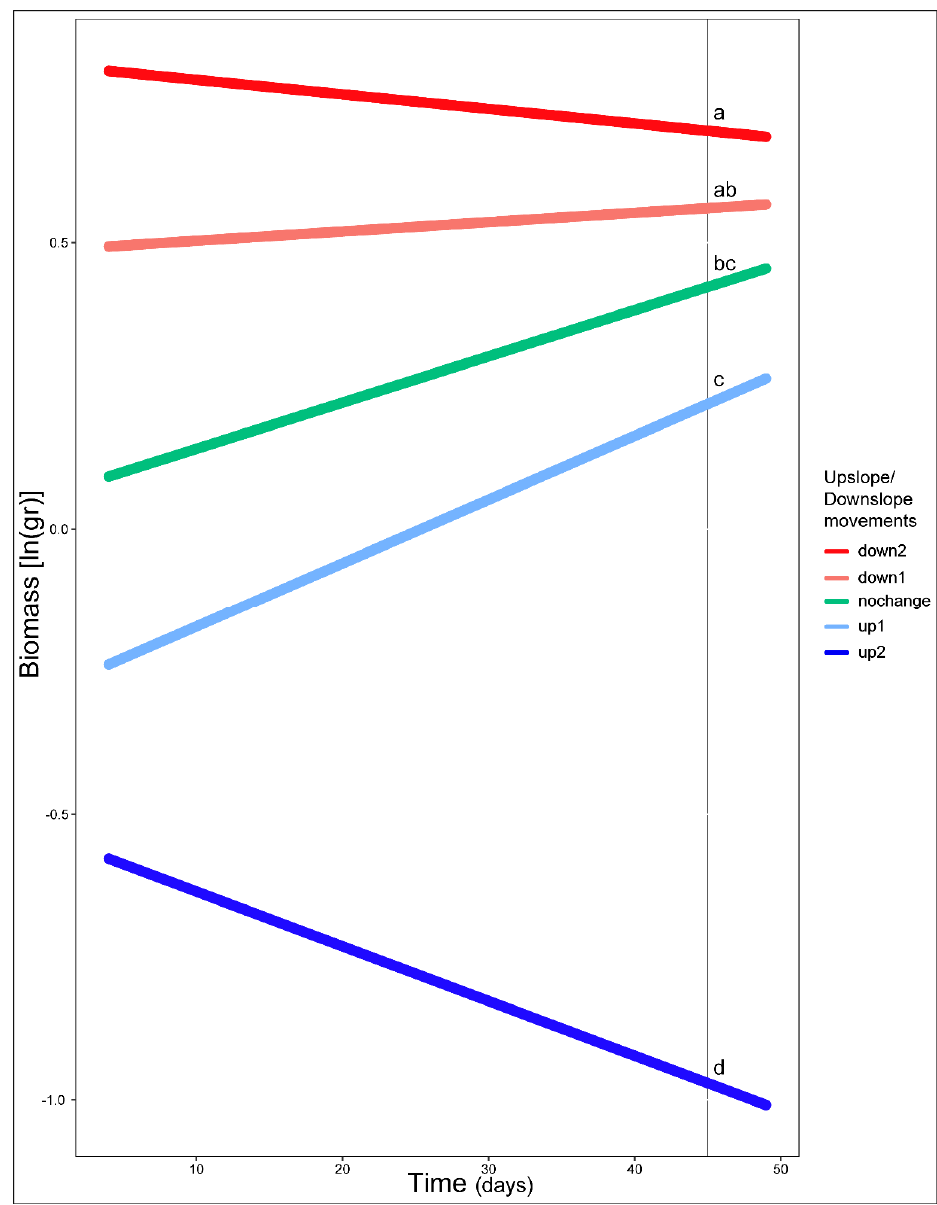
Figure 1. Estimated performance of Erebia caterpillars as predicted for the three temperature treat- ments (low, medium, high) and across time. Lowercase letters indicate differences between treat- ments. Model fitted for individuals that had two or more mass measurements. Note that hatching time slightly varied among larvae, resulting in different biomass at the beginning of weekly meas- urements (see Methods).